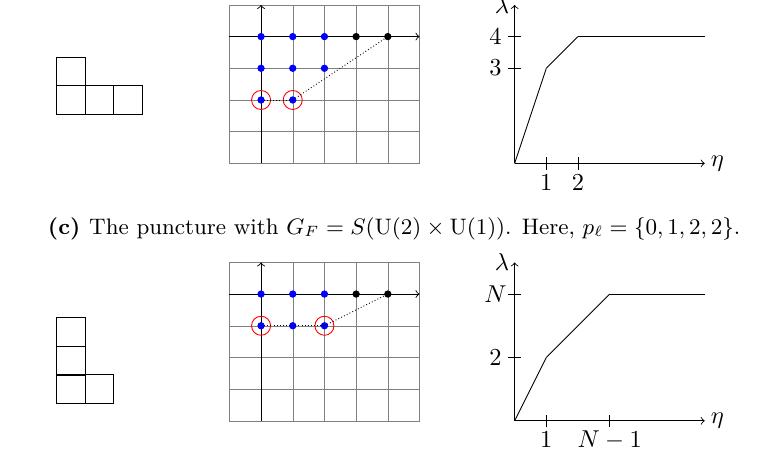
(c) The puncture with G F = S (U(2) × U(1)) . Here, p ‘ = { 0 , 1 , 2 , 2 } .